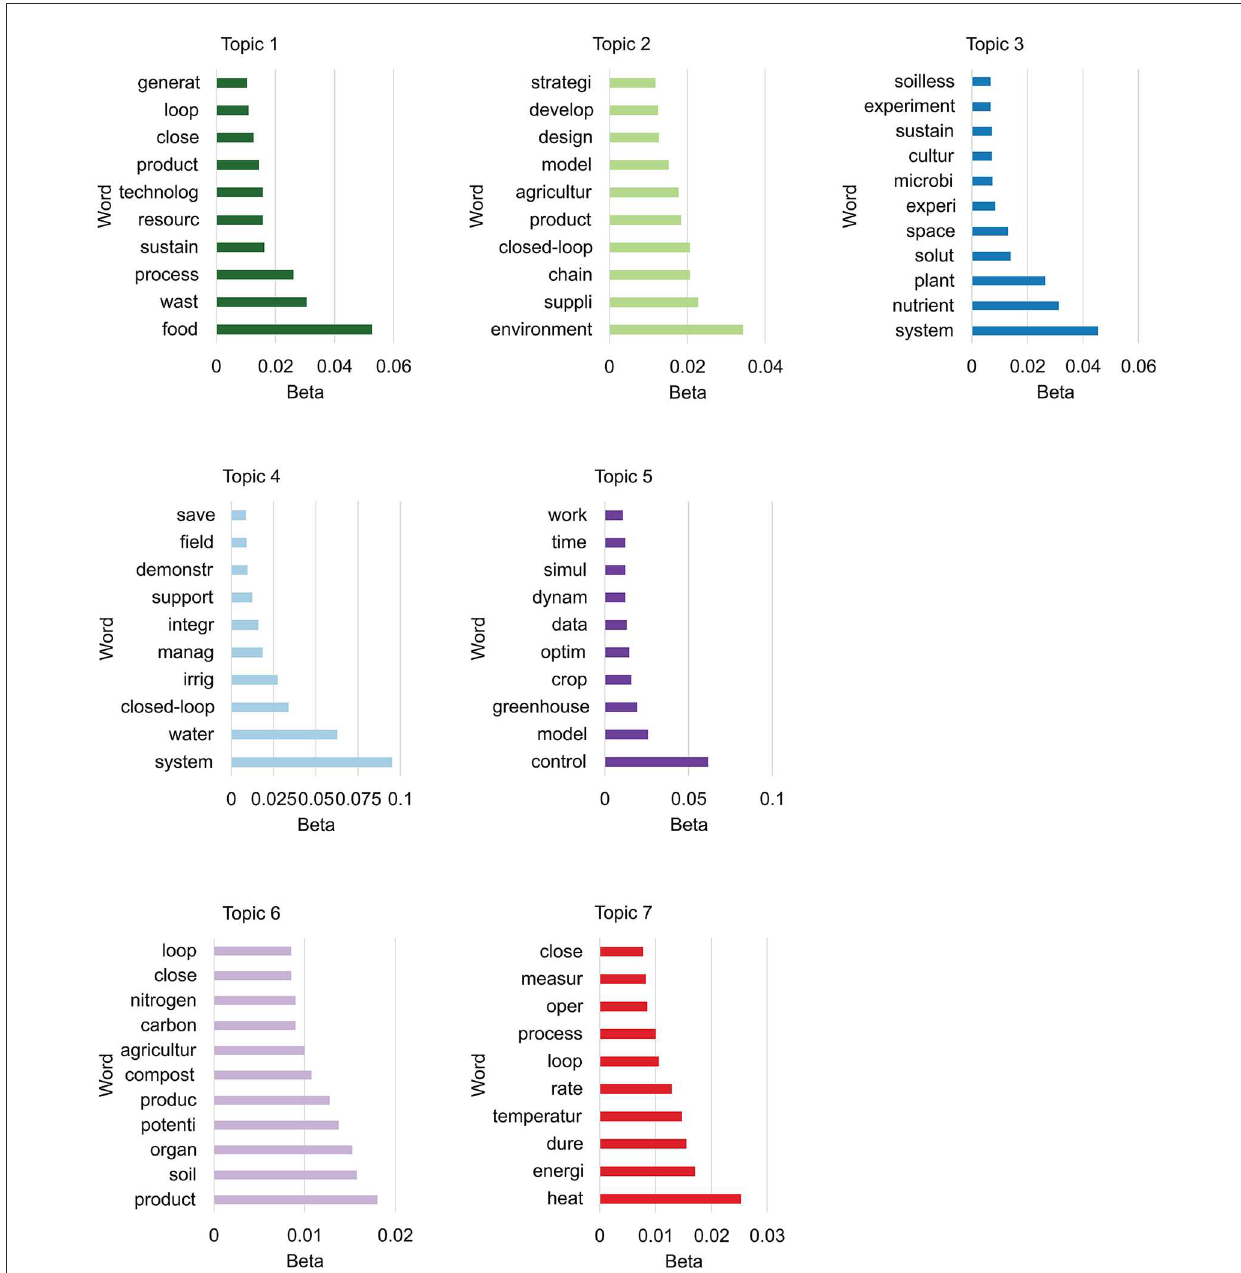
FIGURE5 Beta distributions of each of the topics generated by the text-mining approach. Graphical representation of the frequency of occurrence of various words within a topic. Seven topics are uncovered, with the likelihood of a term appearing within each topic indicated along the